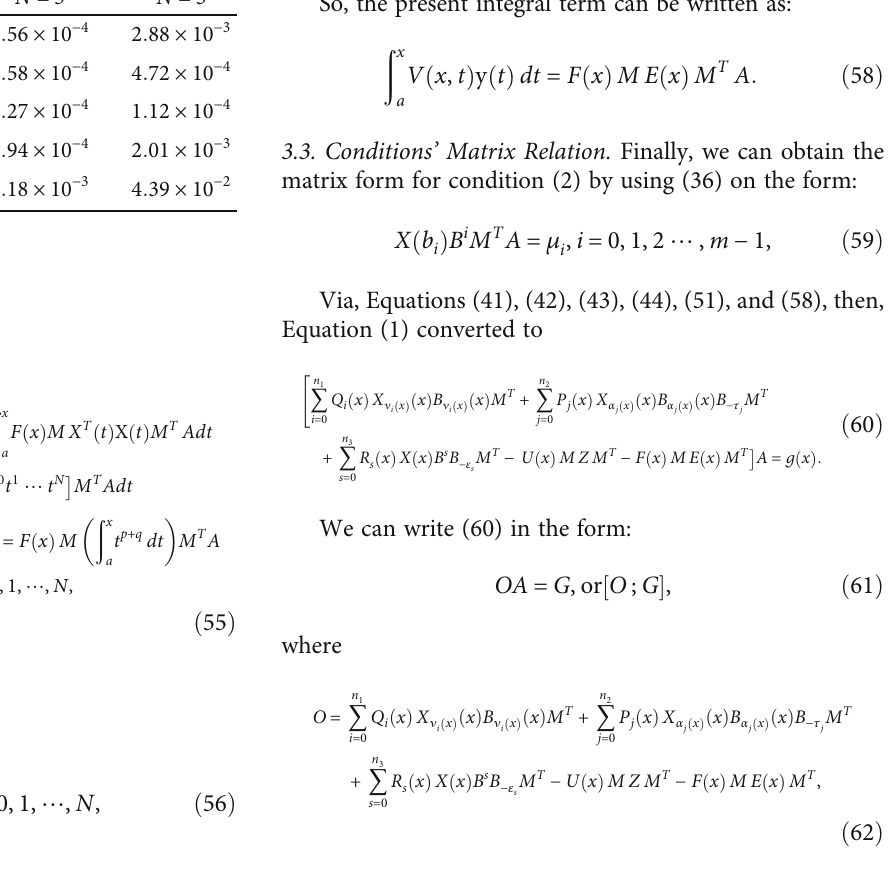
Figure 3: Exact solution and numerical solutions (a), absolute error (b) for Example 2 with three di ff erent values of τ and N = 7 in case α ð x Þ = 1 − cos 2 ð x Þ and h = 1 . Table 4: Comparison of the maximum absolute error of the method given in [45] and the presented method for Example 3 with di ff erent values of N and h = 1 in α ð x Þ = x /2 for Example 3. Absolute errors Our method x